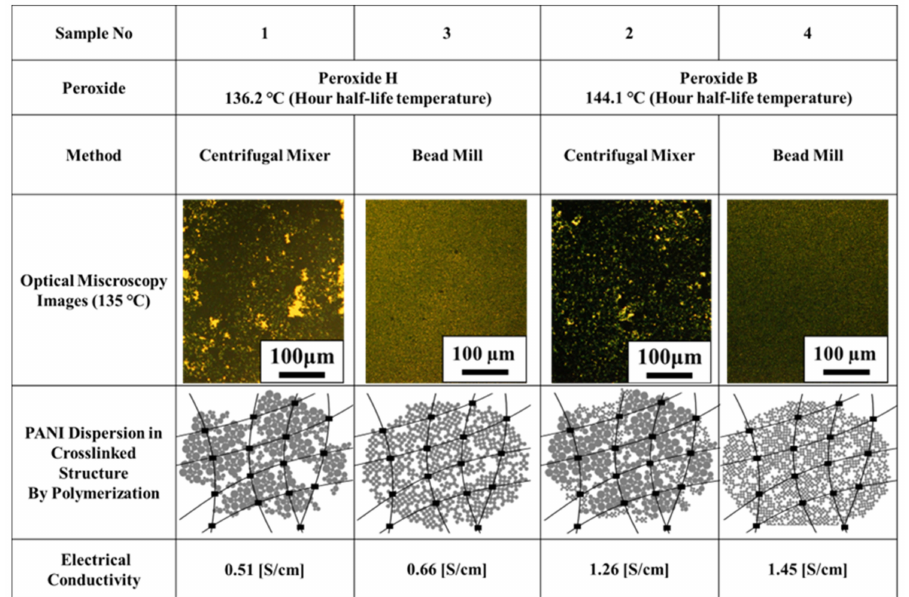
Figure 8. Summary of the thermal doping of PANI/DBSA and differences in the thermal decomposi- tion temperatures of the peroxides and effects on conductive network